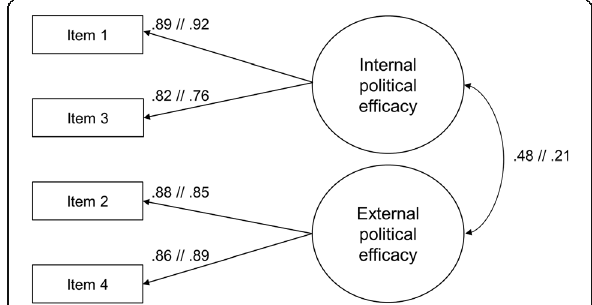
Fig. 1 Two-factor essentially tau-equivalent measurement model of PESS/PEKS with standardized coefficients. The coefficients of the German sample follow those of the UK sample after the double slash. Item error terms have been omitted for clarity. N UK = 468; N DE =